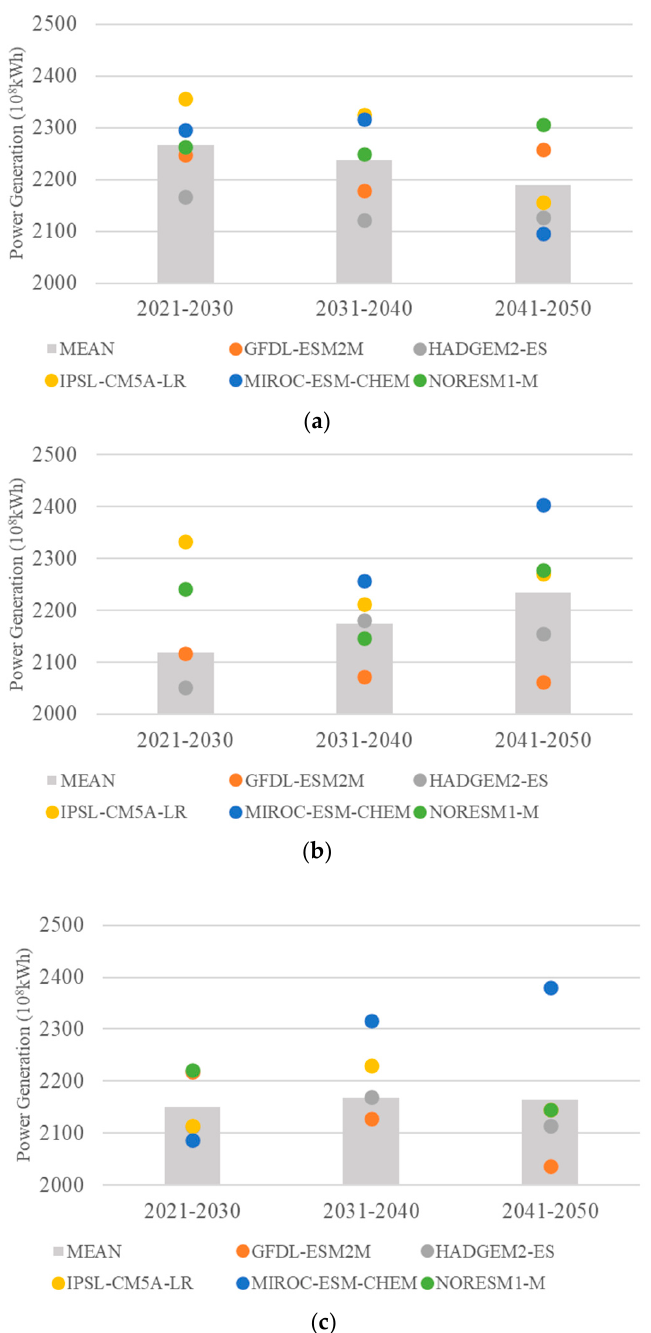
Figure 18. Power generation projections for the next three decades under scenarios: ( a ) RCP2.6, ( b ) RCP4.5, and ( c ) RCP8.5.